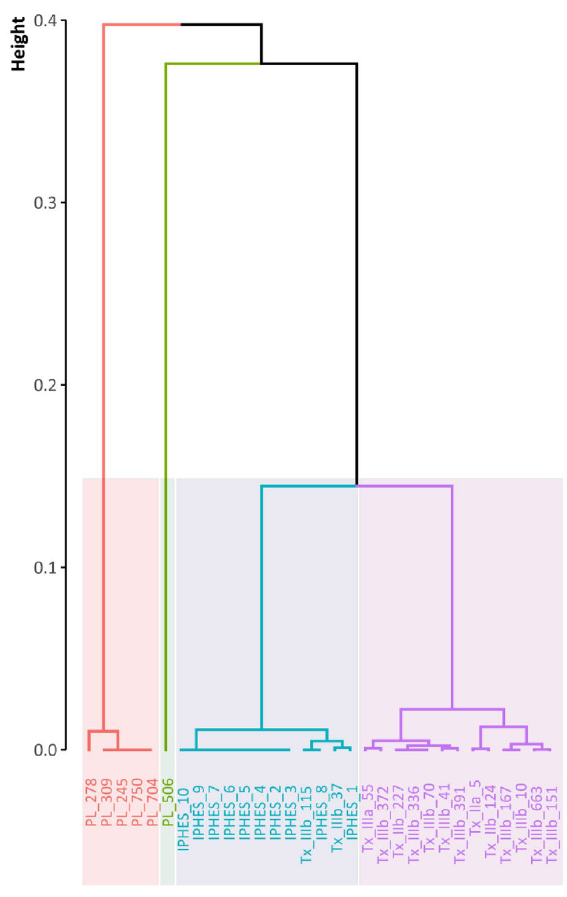
Figure 2. Cluster analysis (Ward’s method) of the first three components of the MCA describing the presence/ absenceof Cervus m2’s morphological parameters (see Supplementary Table S6). The identifiers are the name of the sites (PL = Pié Lombard; IPHES = C. e. hispanicus ; Tx = Teixoneres) followed by the name of the unit (when relevant) and the number of the